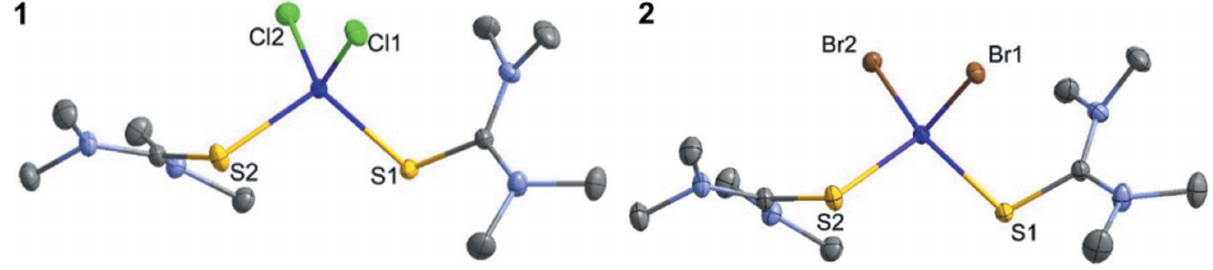
Figure 1 ORTEP drawings of 1 (left) and 2 (right). Thermal ellipsoids showing 90% probability surfaces. Hydrogen atoms have been omitted for